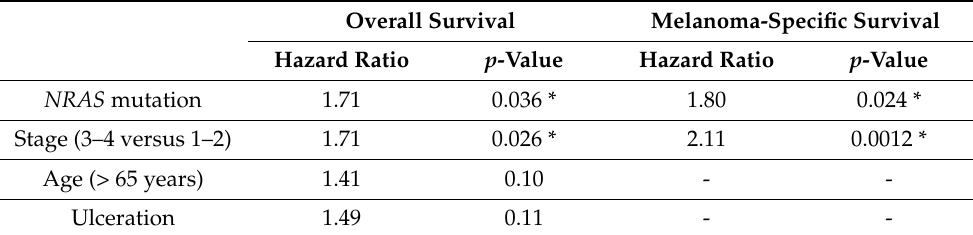
Table 2. Multivariate Cox proportional hazards models.